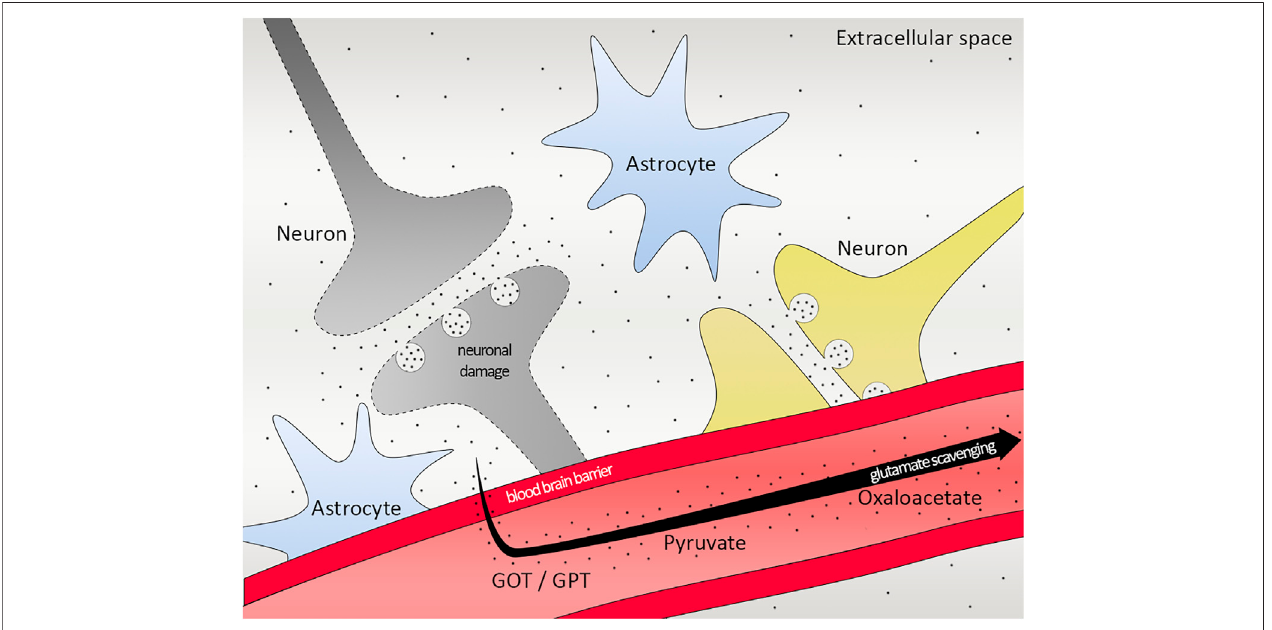
FIGURE6| Schemeofglutamatescavenging.WorkingmechanismofGOT/GPT,pyruvateandoxaloacetateinthebrain.Blackdotsrepresentingglutamate.GOT, Glutamate-oxaloacetate transaminase; GPT, Glutamate-pyruvate transaminase.